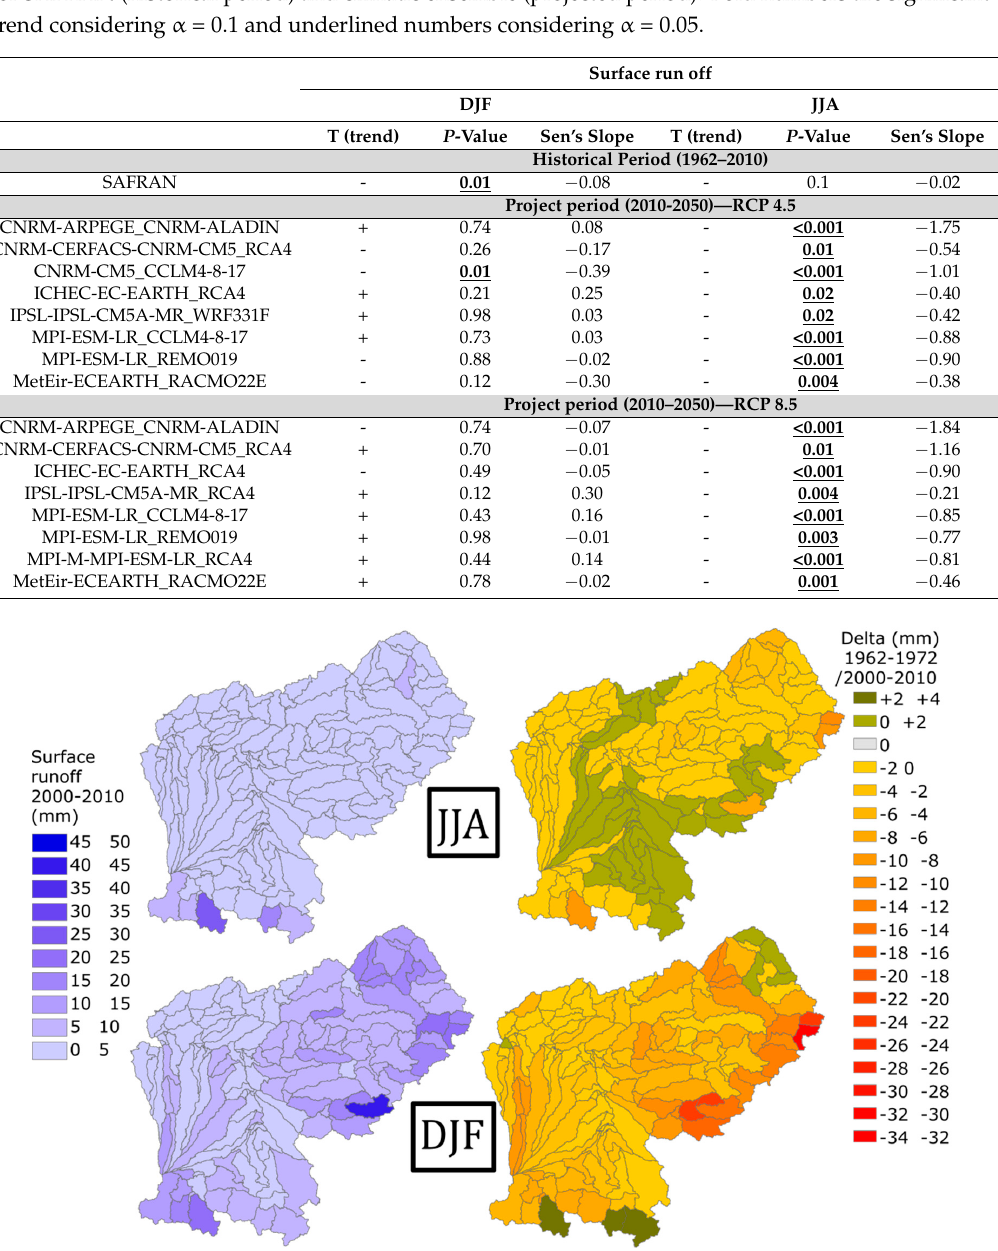
Figure 8. Runoff during the 2000–2010 decade and variations with the 1962–1972 decade.